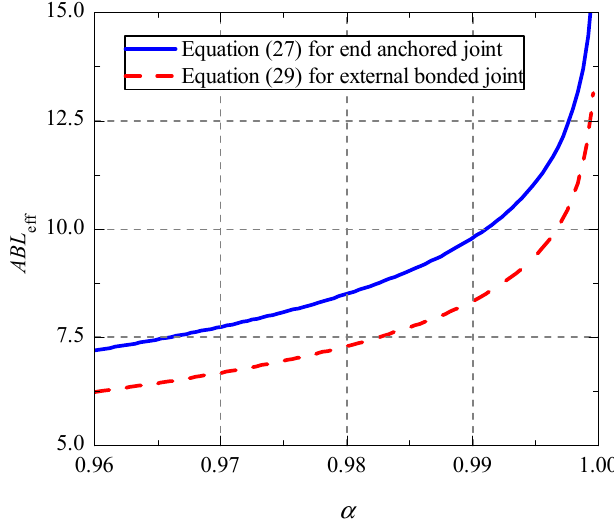
Figure 6. Relationship between effective bond length and ratio α .